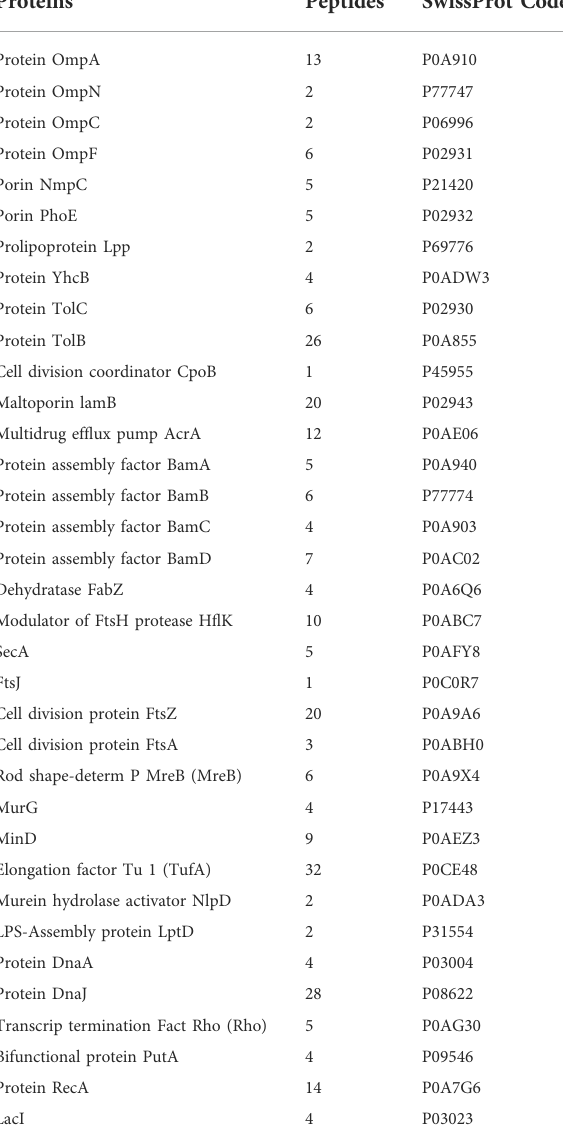
TABLE 1 E. coli proteins identi fi ed as putative Mag-2 interactors. Proteins Peptides